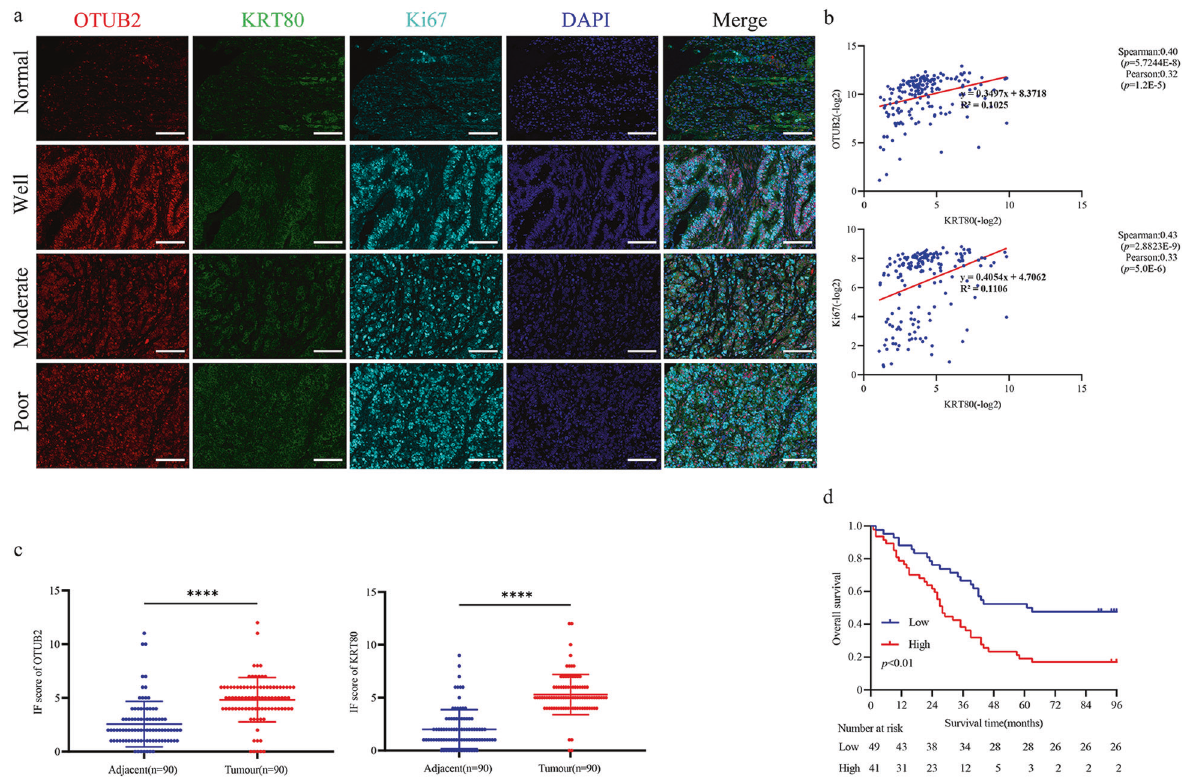
Fig. 2 Multiple immuno fl uorescence (IF) staining analysis in a tissue microarray (TMA). a Representative multiple fl uorophore-antibody (red: OTUB2; green: KRT80; cyan: Ki67; blue: DAPI) staining on the TMA. Scale bar, 400 μ m. b Correlation analysis of KRT80 with OTUB2 and KRT80 with Ki67 protein expression on TMA, respectively, P < 0.05 indicates a signi fi cant outcome. c IF staining scores of OTUB2 and KRT80 expression in 90 paired GC samples. d Kaplan – Meier analysis with a log-rank test was performed in GC patients with varying levels of OTUB2 protein expression. **** P < 0.0001, Student ’ s t